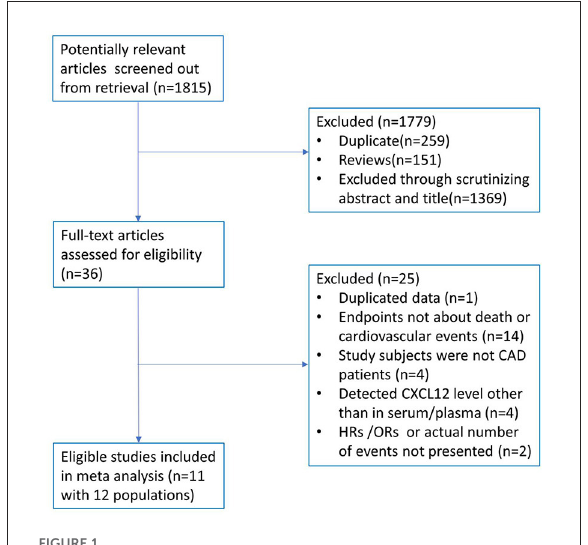
FIGURE1 Flow diagram of the study selection